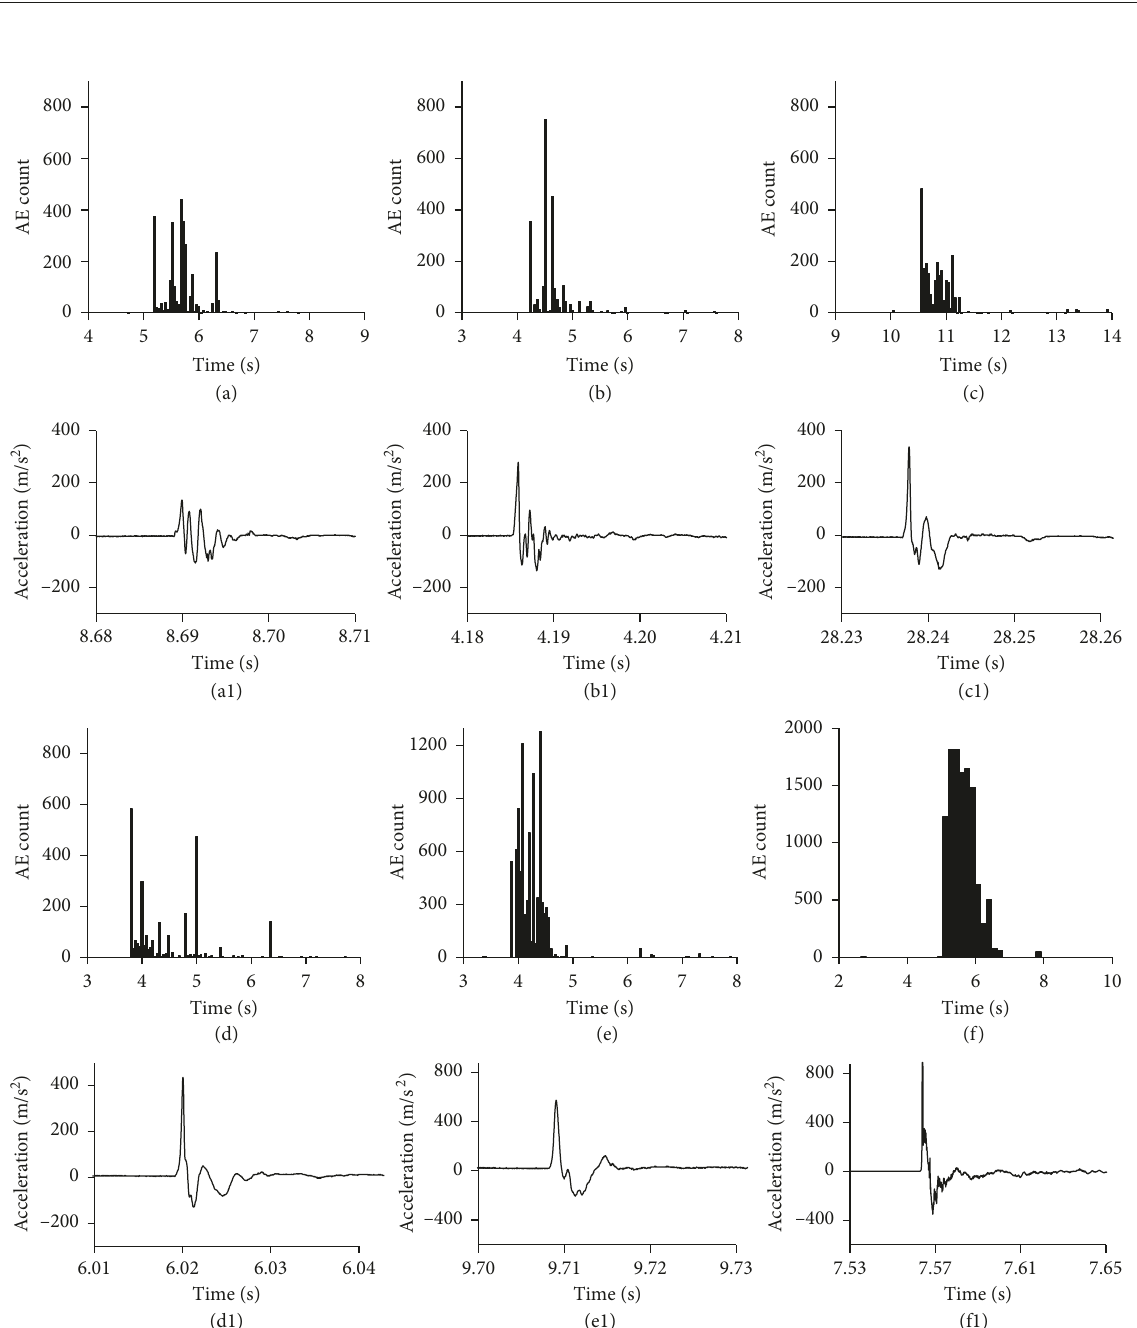
Figure 8: AE activity and acceleration signals at different input energies: (a, a1) 29.4J ; (b, b1) 58.8J; (c, c1) 88.2J; (d, d1) 117.6J; (e, e1) 147J; (f, f1)